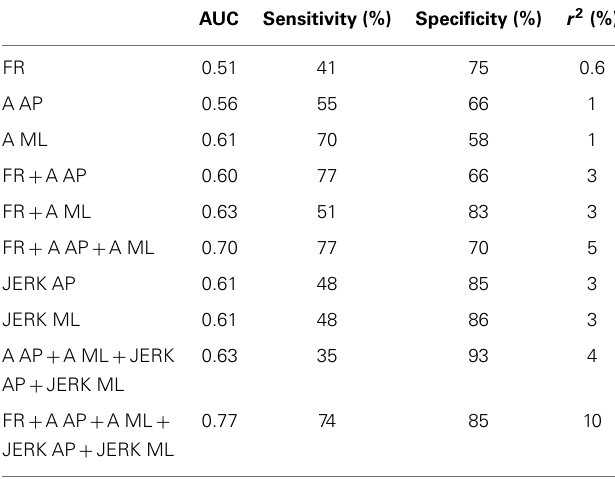
Table 3 |Area under the curve (AUC), sensitivity, and specificity, as well as r 2 of combinations of parameters, which have been found to be significantly different between patients with Parkinson’s disease (PD) and controls, and which have previously shown to be altered in individuals with high risk for future PD (HRPD) (Maetzler et al., 2012), for the discrimination of HRPD from controls .